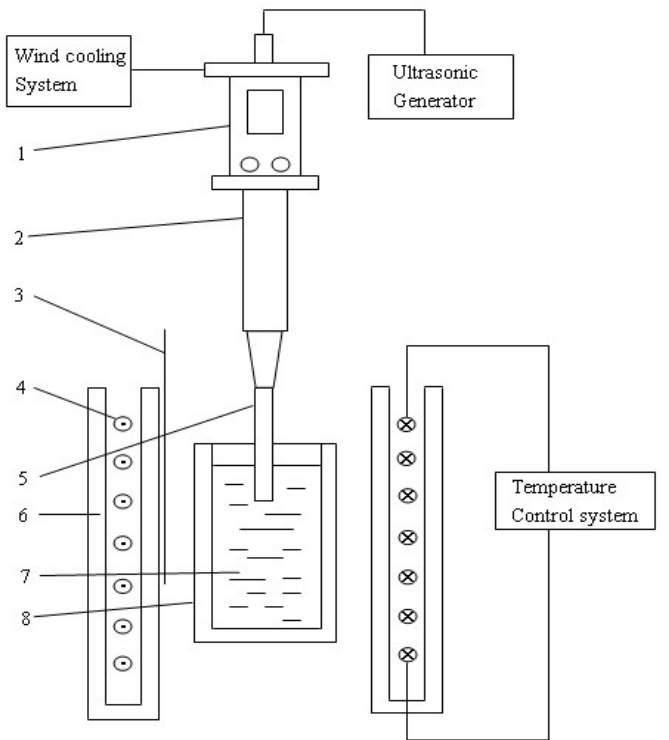
Figure 1. Schematic diagram of the ultrasonic treatment experimental set-up. 1—Ultrasonic trans- ducer; 2—Cone; 3—Thermocouple; 4—Resistance heater; 5—Ultrasonic radiator; 6—Ceramic tube; 7—Mg-3.03Ca alloy melt; 8—The iron crucible.